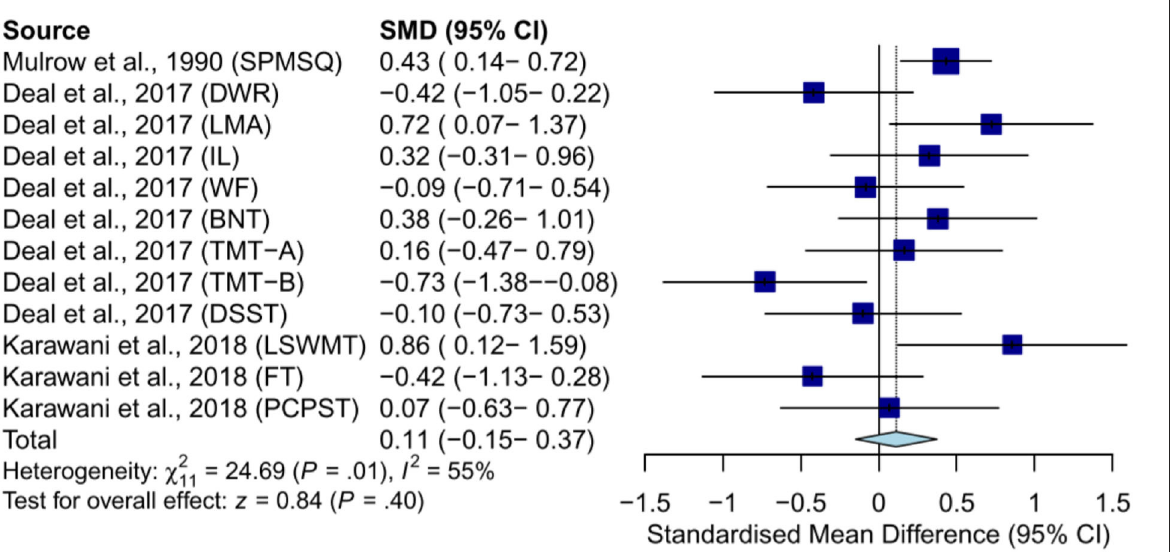
FIGURE2 Meta-analysis of SMD (random-effect model) in effects of hearing aids on cognition in subjects without dementia. SPMSQ, Short Portable Mental Status Questionnaire; DWR, delayed word recall; LMA, logical memory A; IL, incidental learning; WF, word fluency (F, A, S); BNT, Boston Naming Test; DSST, Digit Symbol Substitution Test; LSWMT, List Sorting Working Memory Test; FT, Flanker Test; PCPST, Pattern Comparison Processing Speed Test.